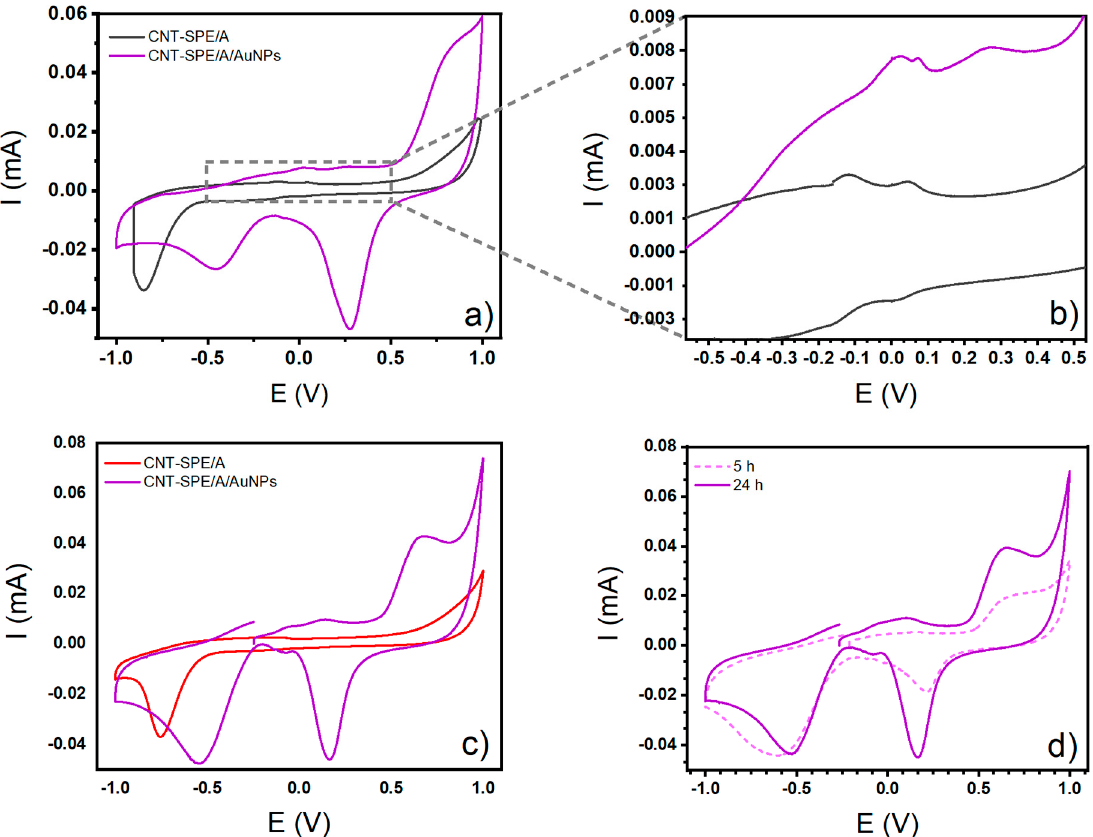
Figure 10. Cyclic voltammogram curves of ( a ) Sorensen buffer (support electrolyte @ pH = 7) on CNT-SPE/A and CNT-SPE/A/AuNPs, ( b ) close up of the oxidation peaks of CNT-SPE/A and CNT-SPE/A/AuNPs on the support electrolyte, ( c ) glucose 8 mM studied on CNT-SPE/A and glucose 8 mM on CNT-SPE/A/AuNPs after 24 h modification, ( d ) glucose 4 mM on CNT-SPE/A/AuNPs after 5 and 24 h modification.